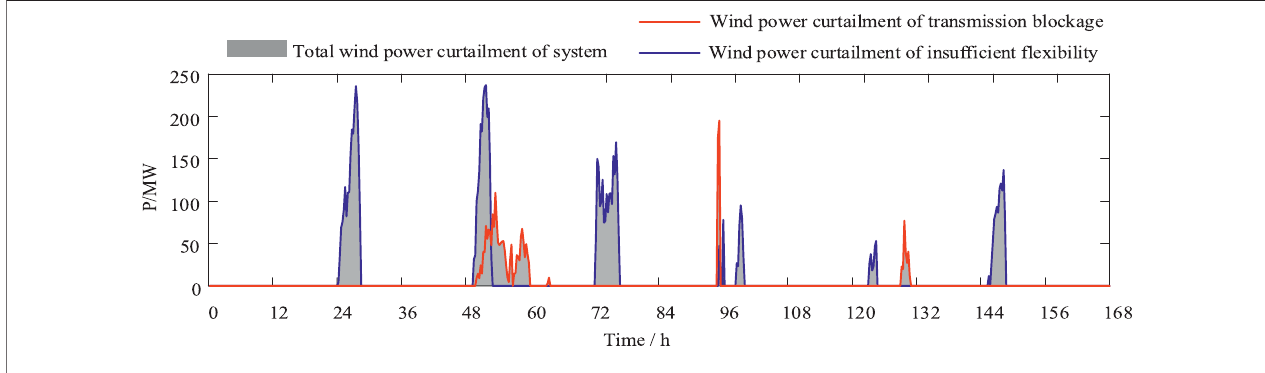
FIGURE 3 | The coupling of insuf fi cient fl exibility and blocked wind power